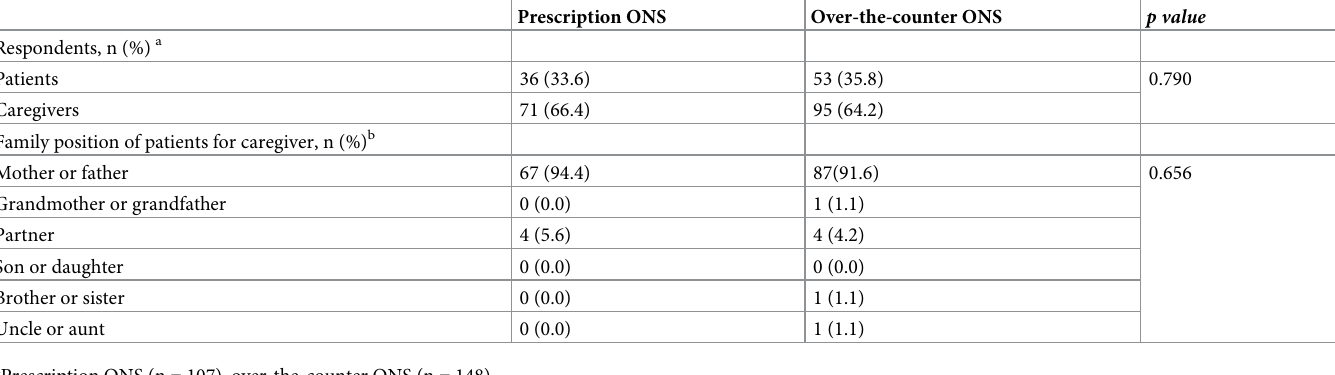
Table 2. Respondent